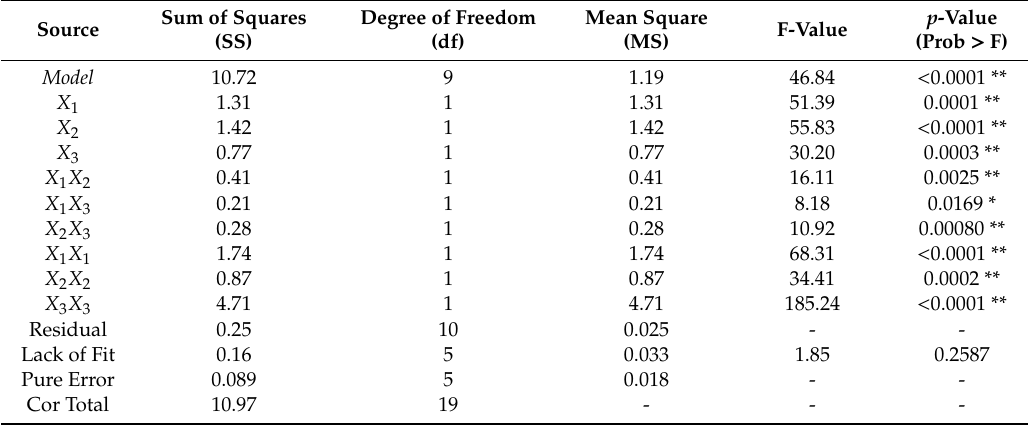
Table 3. ANOVA for the response surface quadratic model.